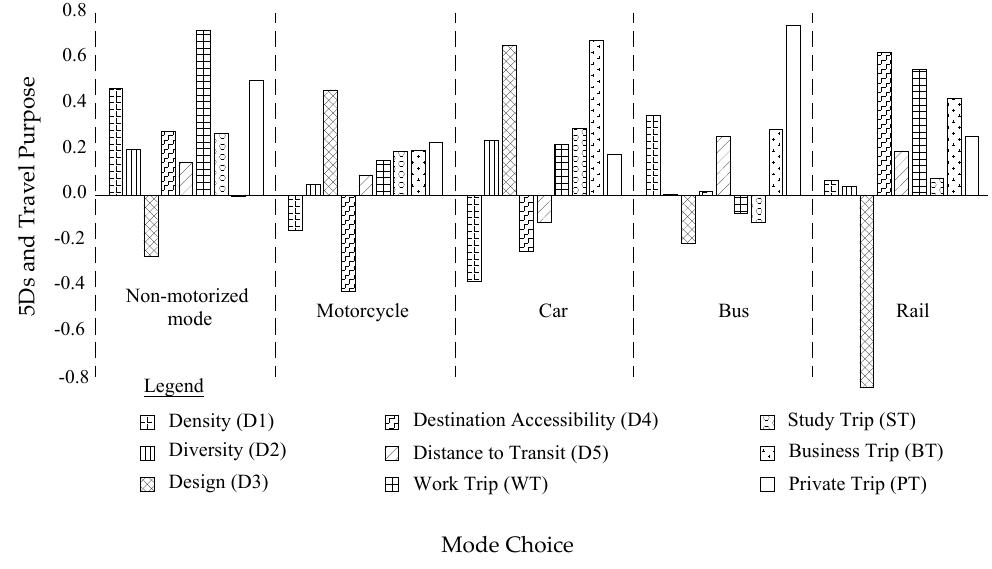
Figure 6. Effect of 5Ds and travel purpose on mode